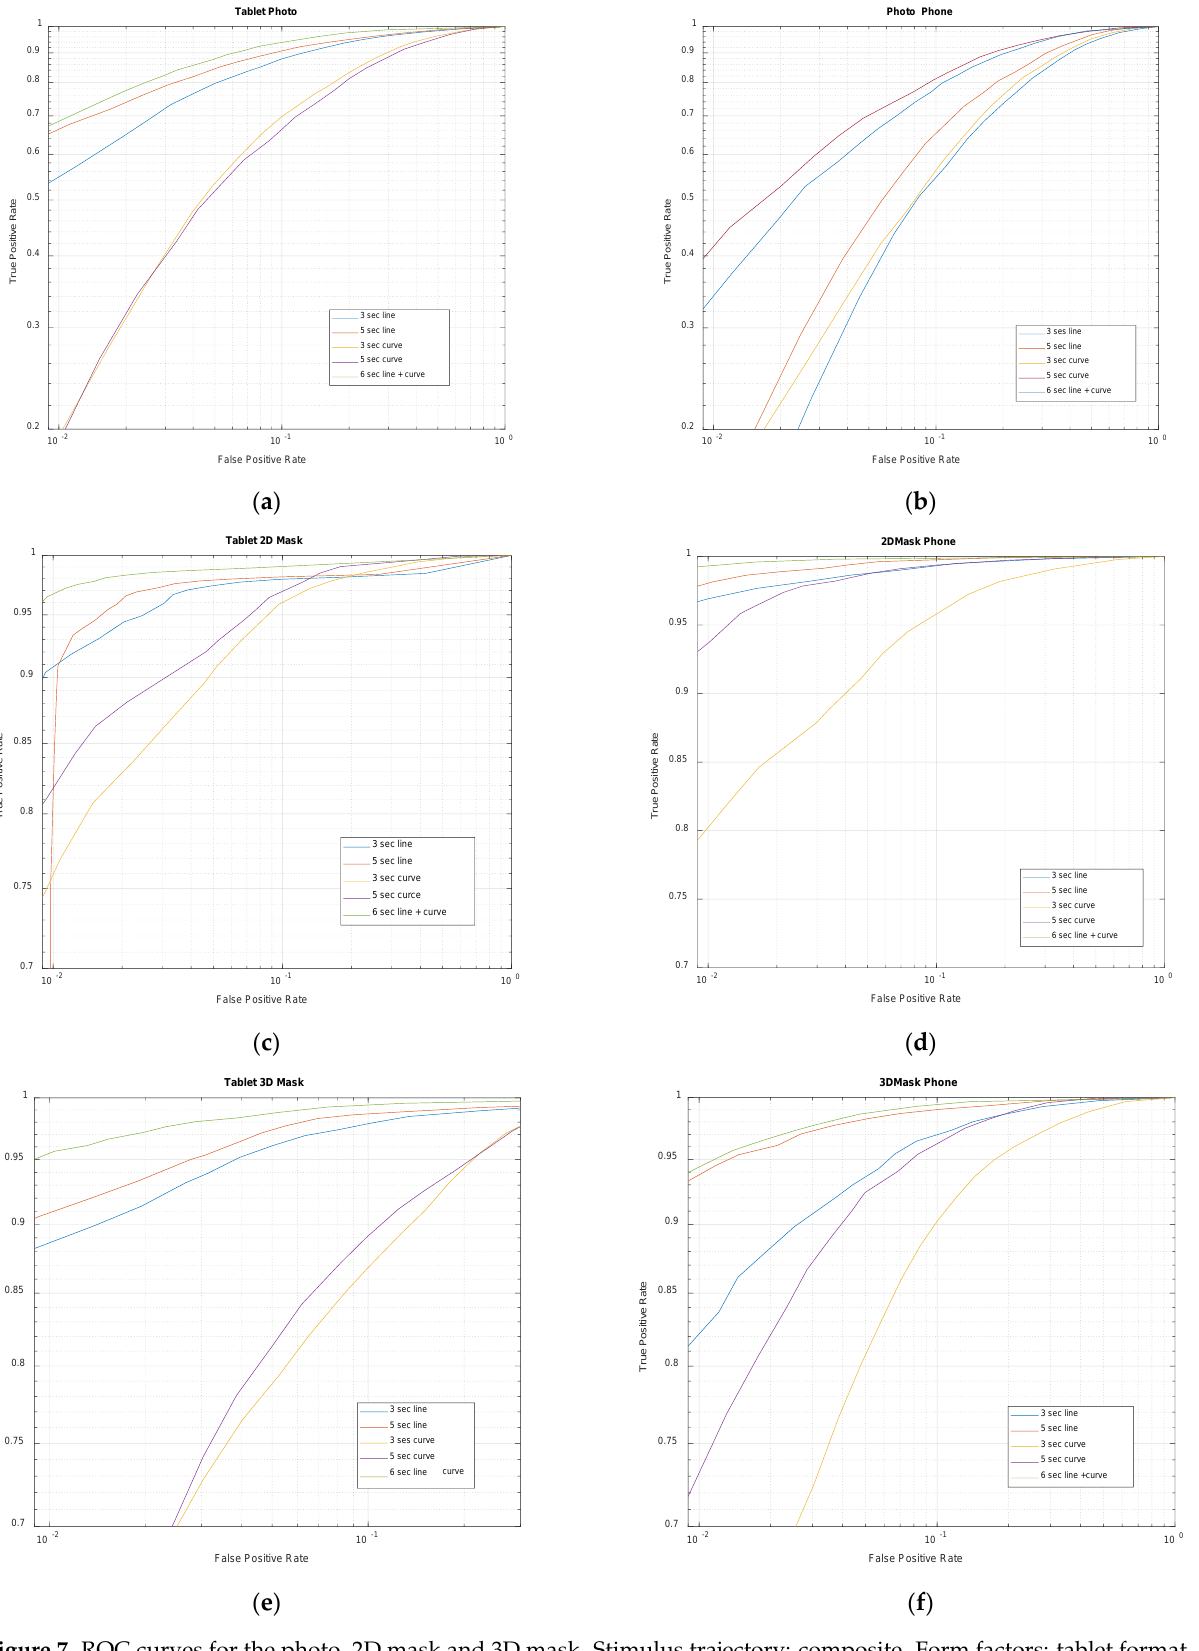
Figure 7. ROC curves for the photo, 2D mask and 3D mask. Stimulus trajectory: composite. Form factors: tablet format ( left ) and phone format ( right ). [The plot titles indicate the device format as well as the attack artefact.]